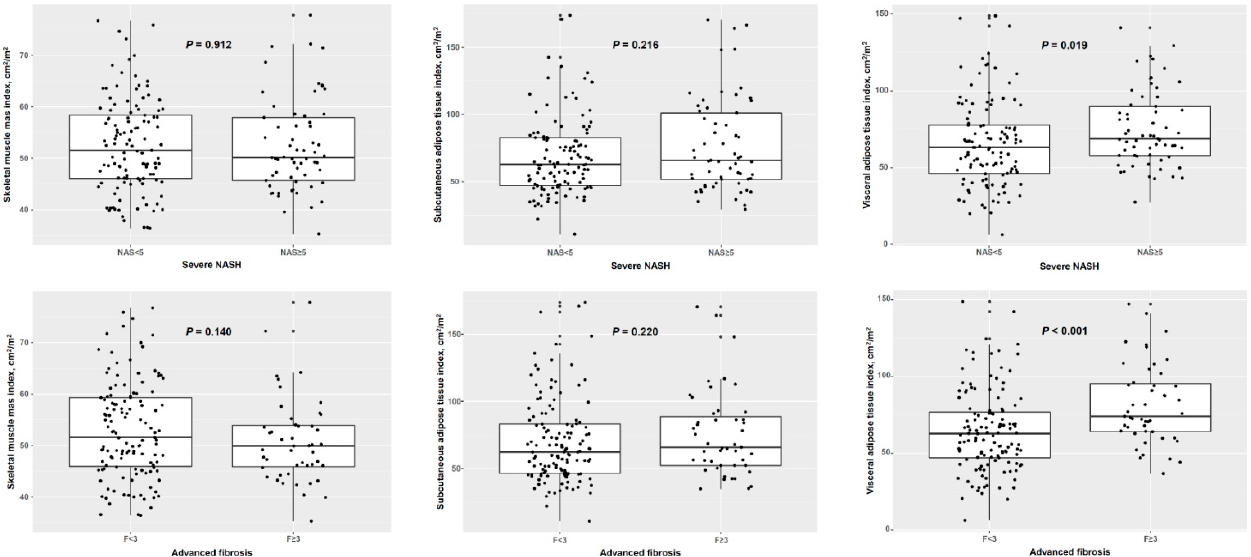
Figure 1. Adipose tissue distribution and skeletal muscle mass according to severe non-alcoholic steatohepatitis and advanced fibrosis. NASH, non-alcoholic steatohepatitis.